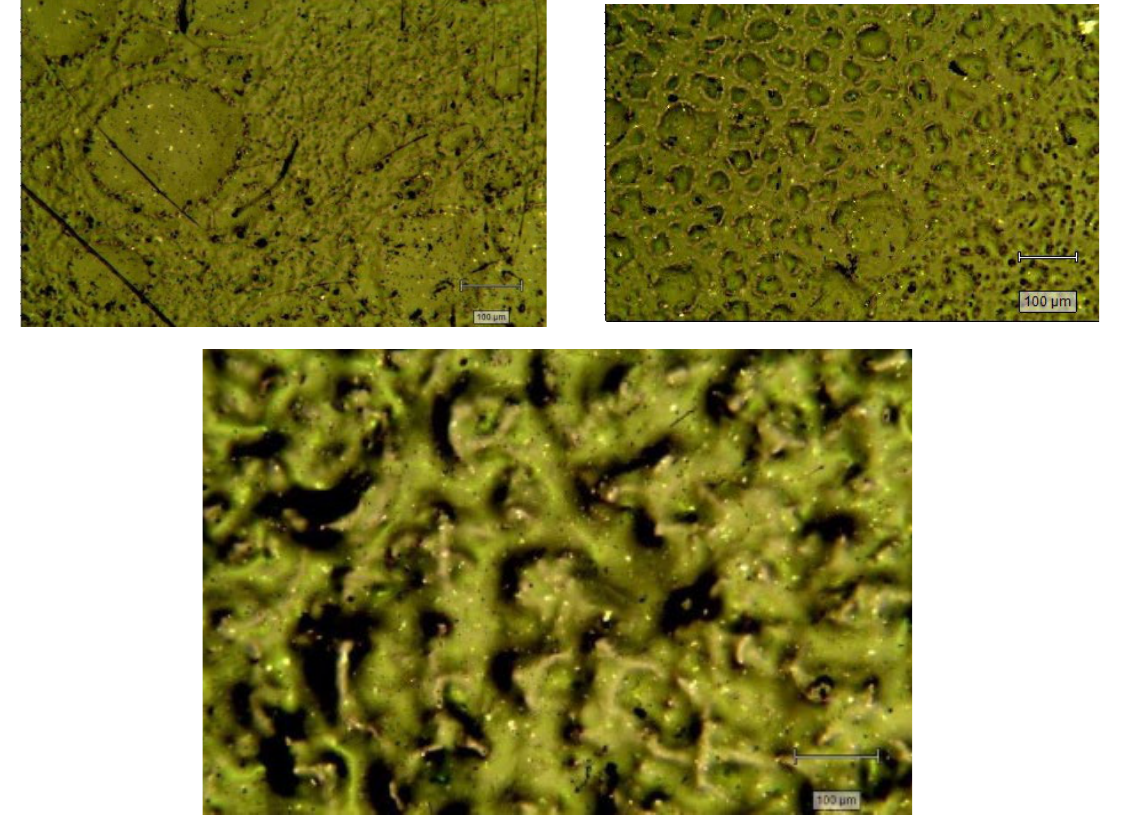
Figure 1. Epoxy/GNP thin film thickness trend (1000 rpm) as GNP concentration varies.